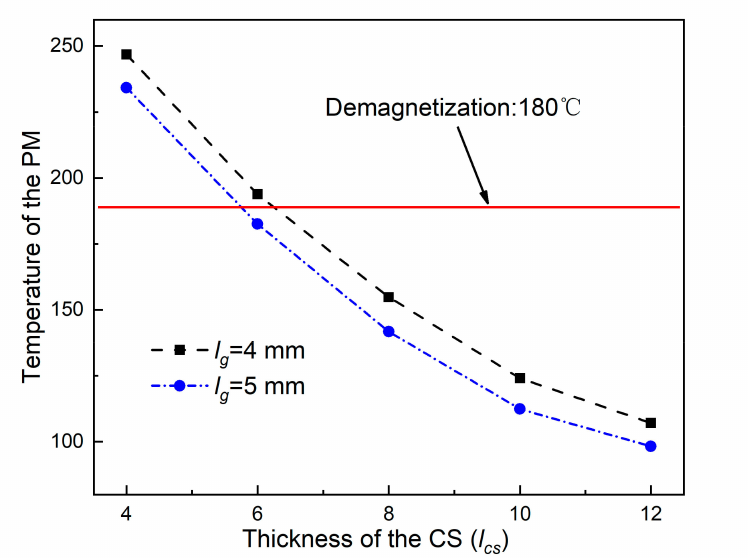
Figure 20. The relationship between the temperature of the PM and the thickness of the CS ( s = 120 r /